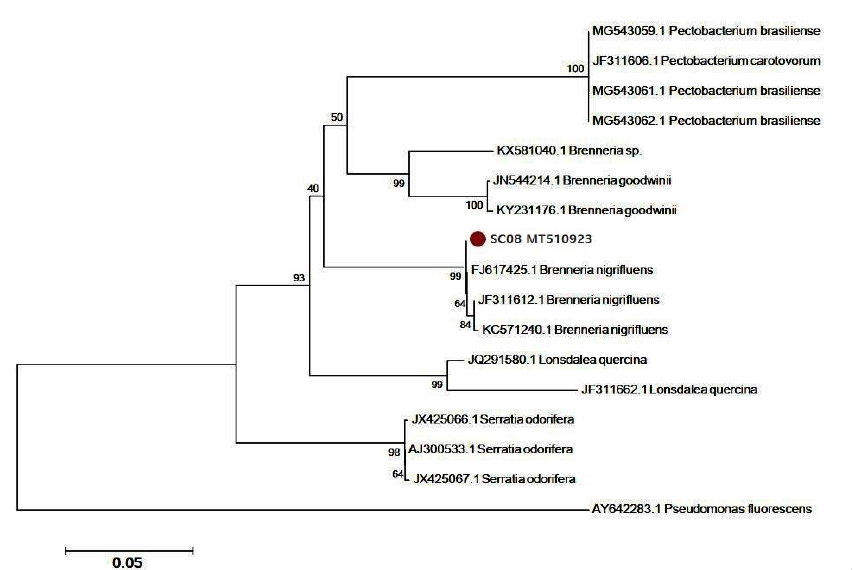
Fig. 6. Phylogenetic analysis of representative strain and related species by the Neighbor-Joining method based on gyrB gene sequences: The GenBank accession number for each microorganism used in the analysis is shown behind the species name. Bootstrap values are shown at the nodes. The tree was rooted with Pseudomonas fluorescens